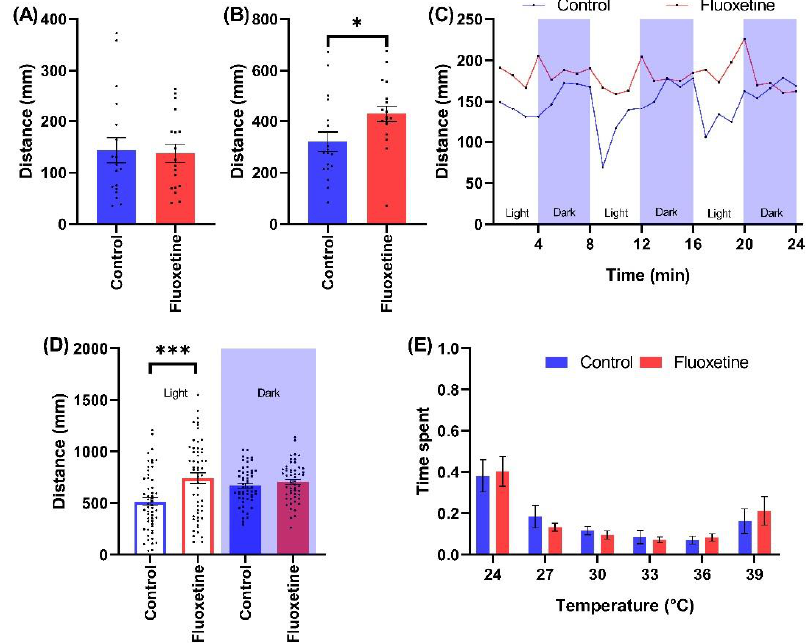
Figure 5. The effects of fluoxetine (300 ng/L) exposure on wild type zebrafish behavioral indices during the testing battery in ( A ) Spontaneous swimming, ( B ) SPR, ( C ) Time resolved LPR, ( D )